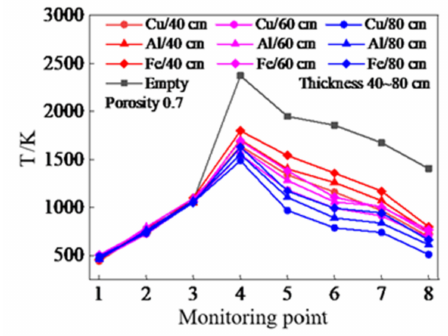
Figure 8. Maximum temperature at each monitoring